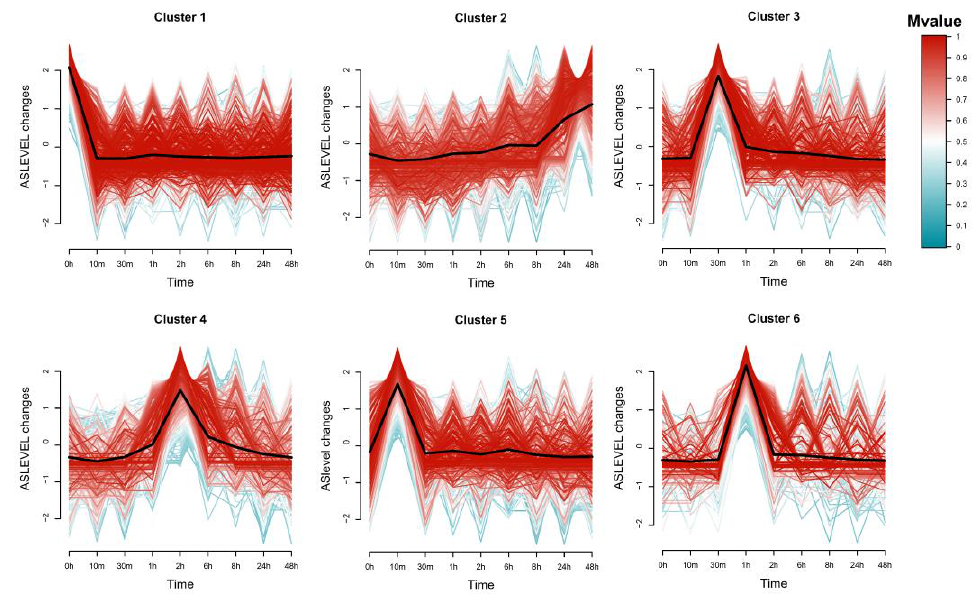
Figure 3. Results of Time-series Clustering. Different clusters represent AS events with different ASLEVEL change trends, respectively. Among them, Cluster 1 and Cluster 2 significantly decreased or increased ASLEVEL under nitrogen starvation. The black line of each cluster means the cluster centre for that cluster. Mvalue: Membership value.